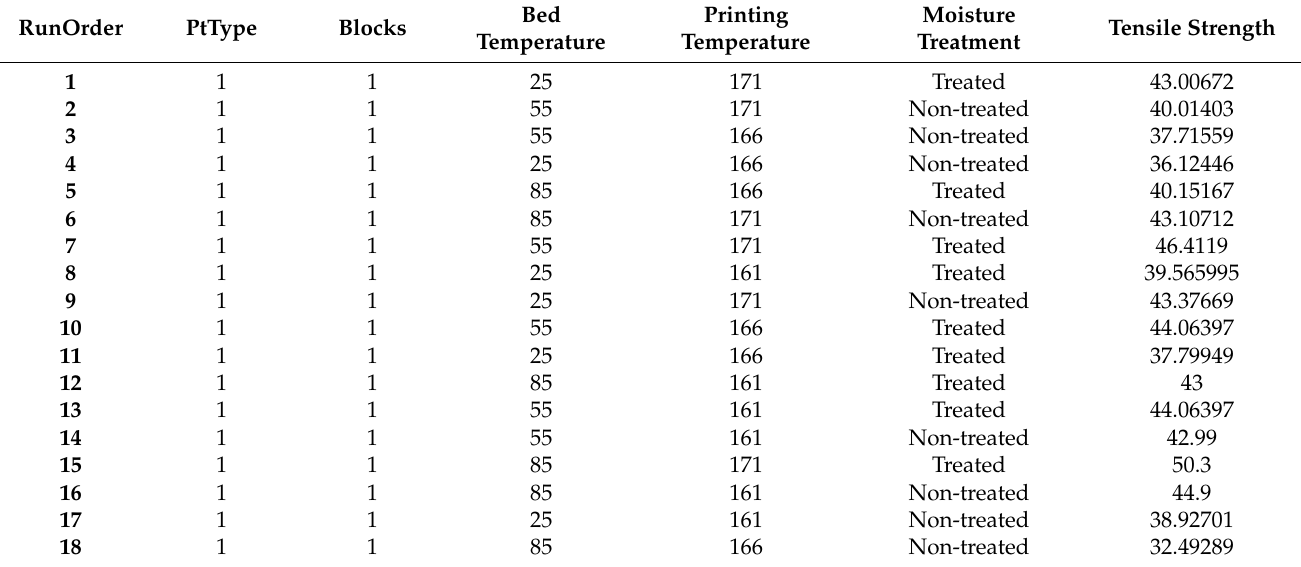
Table 5. DoE for second ANOVA of water absorbed samples.